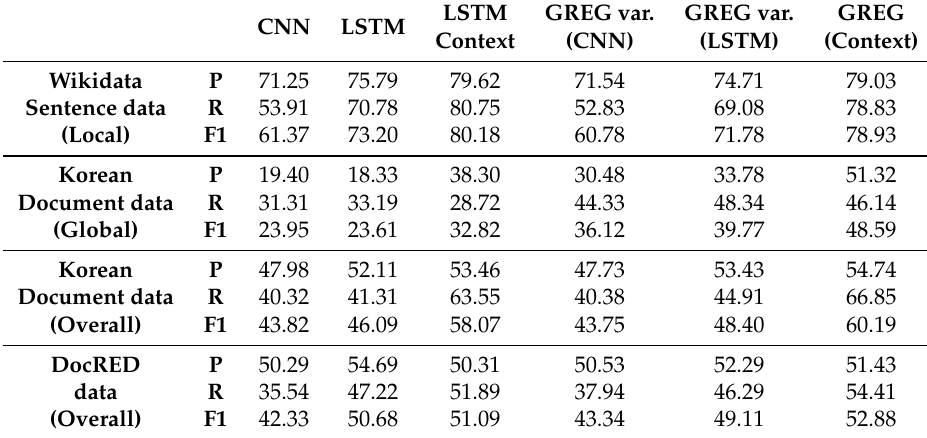
Table 2. Performance comparisons on three different levels: Local relations, Global relations, Overall relations by the use of Precision(P), Recall(R) and F1-score(F1) (%) CNN LSTM